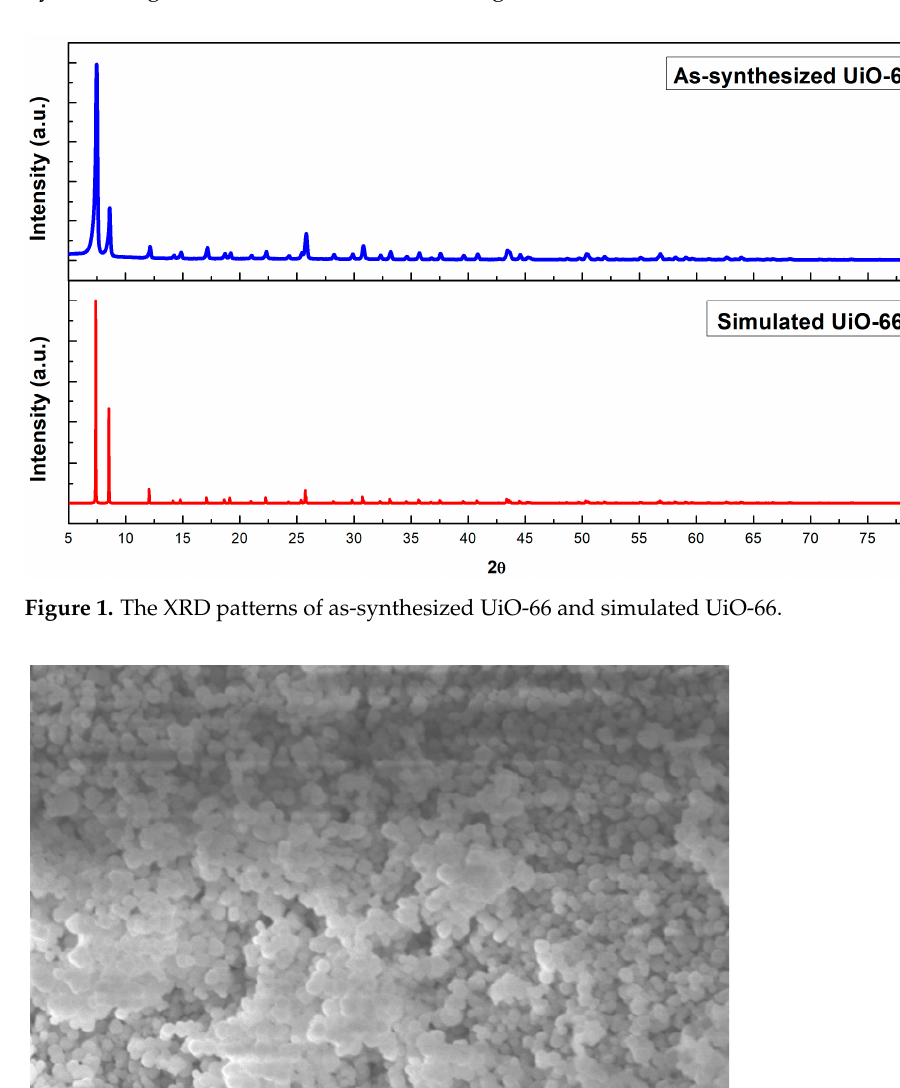
Figure 3. The surface of IL@UiO-66 at 2 µm. The energy dispersive spectrum was calculated for each sample during the micro- graph analysis to identify the elemental composition of UiO-66 and IL@UiO-66. The atomic percentages of each element are presented in Figures 4 and 5. For UiO-66, the car- bon has the highest atomic percentage (66.86%), followed by oxygen (31.07%) and